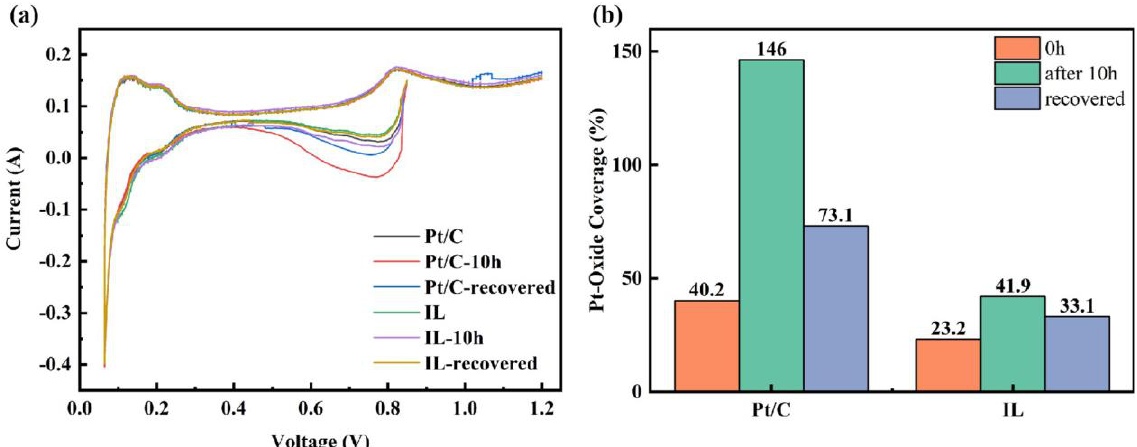
Figure 3. Pt oxide coverage curve of Pt/C and Pt/C + IL ( a ) and Pt oxide coverage statistics ( b ).